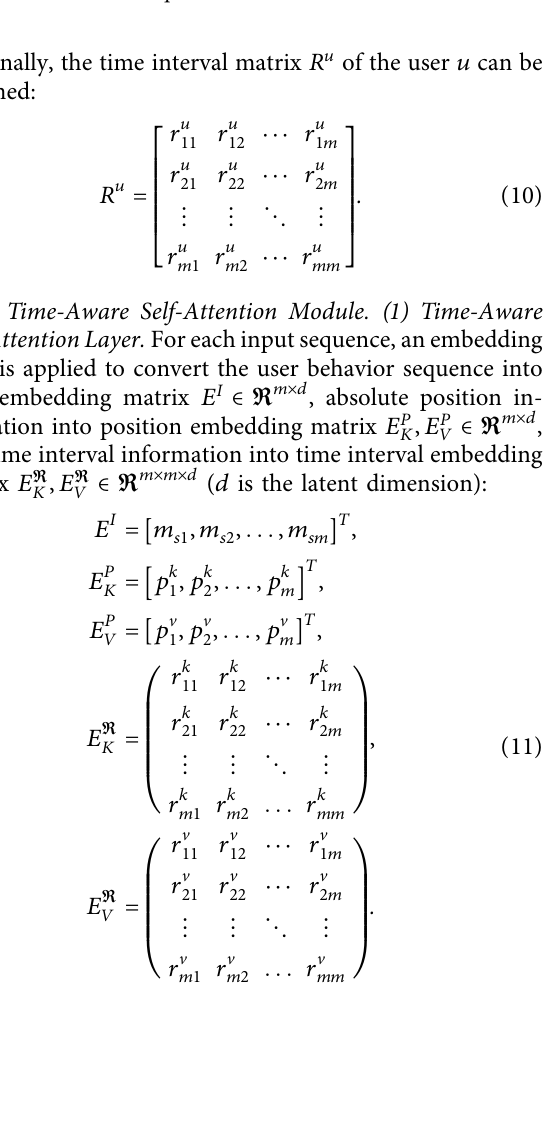
Figure 5: The framework of the proposed model, where T u rep- resents the time series of user u ; R u is the time interval matrix of user u ; r u ij is the element in the time interval matrix R u ; S u rep- resents the behavior sequence of user u ; and S is the absolute position information sequence of the